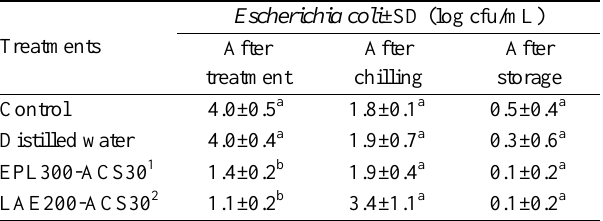
Table 4. Mean counts of Escherichia coli on chicken carcasses after spray treatment with distilled water, EPL300-ACS30 or LAE200-ACS30, after chilling and after 10 days of storage